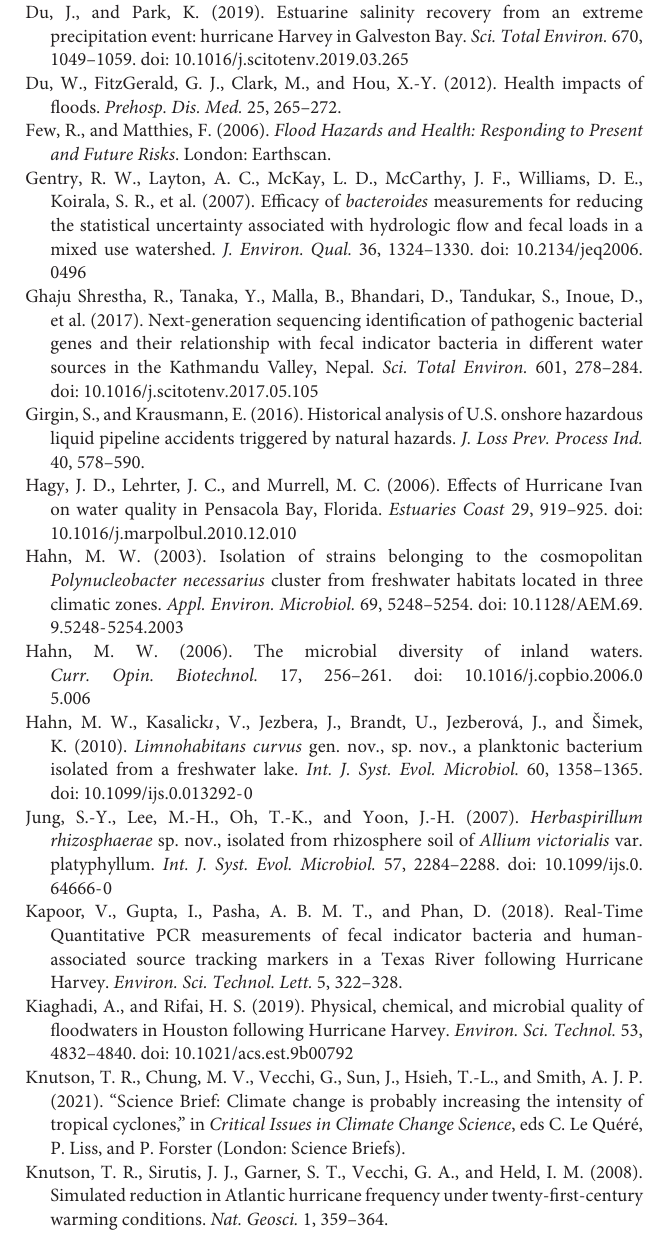
relationship with community structure are shown. Only samples with DIN data available are shown. Note conductivity and salinity vectors were practically identical to each other and would overlap, so only salinity vector is shown. Figure was generated with scripts in Supplementary File 8 . Supplementary Figure 13 | Waterfall plot showing pathways enriched (red) or depleted (teal) in comparison of samples collected before or immediately after Hurricane Harvey. Figure was generated with scripts in Supplementary File 15 . Supplementary Figure 14 | Waterfall plot showing pathways enriched (red) or depleted (teal) as function of salinity concentration. Figure was generated with scripts in Supplementary File 15 . Supplementary Figure 15 | Waterfall plot showing pathways enriched (red) or depleted (teal) as function of nitrate concentration. Figure was generated with scripts in Supplementary File 15